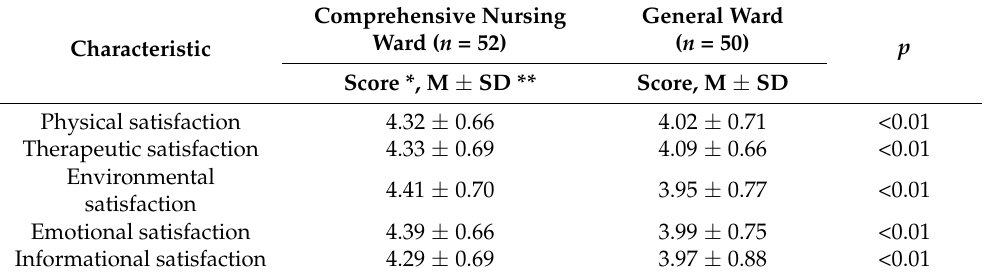
Table 3. Scores using the patient satisfaction index ( n = 102).